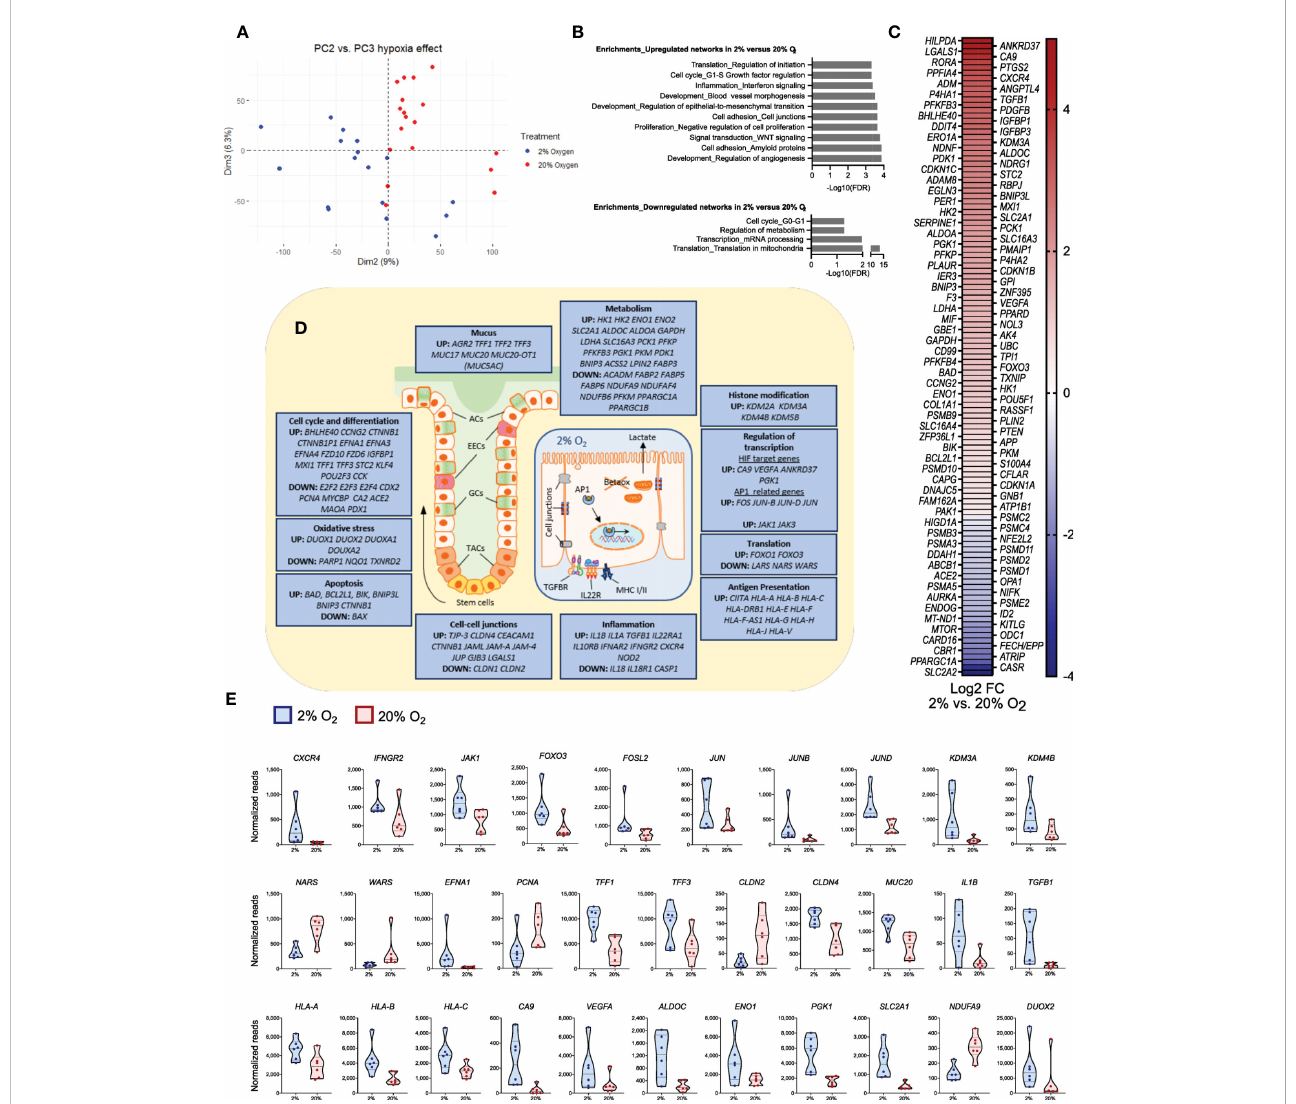
FIGURE 7 Signi fi cant changes in epithelial gene expression after a short time reduction of oxygen. The panels show data from bulk RNA-seq analysis of differentiated colonoids grown continuously at 20% or at 2% for the last 40 hours. (A) PCA plot of PC2 vs . PC3 for the complete dataset from GSE172404 (38) captures the in fl uence of oxygen levels. Dots represent individual samples. (B) Enrichment analysis of basal gene expression in colonoids grown at 2% compared to 20% oxygen. Networks (top ten) best associated with upregulated genes (n=1192) and networks (top four) best associated with downregulated genes (n=1192), analyzed using MetaCore ™ version 6.34 build 69200. The strength of association is given as -Log10 false discovery rate (FDR). (C) Differential expression of curated hypoxia-related genes (n=119) in 2% oxygen compared to 20% oxygen (adjusted P-values < 0.05). The heatmaps are sorted from highest (red) to lowest (blue) log2 fold change (FC) values, with 89 upregulated and 30 downregulated genes in 2% compared to 20% O 2 . (D) Illustrations of a colonic crypt with mucus lining and a colonic epithelial cell. The blue boxes contain a selection of differentially regulated genes between colonoids at 2% or 20% oxygen (adjusted P-values < 0.05), grouped by intestinal epithelial cell functions. Upregulated or downregulated genes at 2% compared to 20% oxygen are mentioned in boxes according to the topic. ACs, absorptive cells; EECs, enteroendocrine cells; GCs, goblet cells; TACs, Transit-amplifying cells; TGFBR, transforming growth factor beta receptor; IL22R, Interleukin 22 receptor complex; Betaox, beta-oxidation of fatty acids; MHC, major histocompatibility complex; AP1, network of transcription factors involved in in fl ammation. (E) Expression of a subset of genes within the different groups of intestinal epithelial cell functions described in (D) , given as normalized reads. The fi rst 12 panels show genes related to signal transduction, transcription, and translation; the latter show effector genes important for intestinal epithelial cell homeostasis. See main text for details. All displayed genes in the fi gure panels were differentially regulated with an adjusted P-value